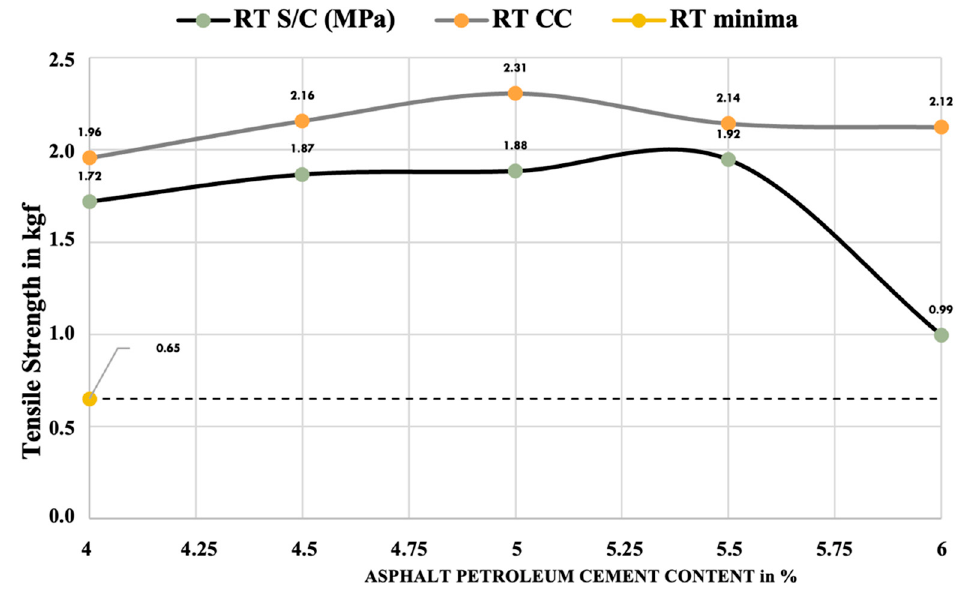
Figure 5. Tensile Strength Test.